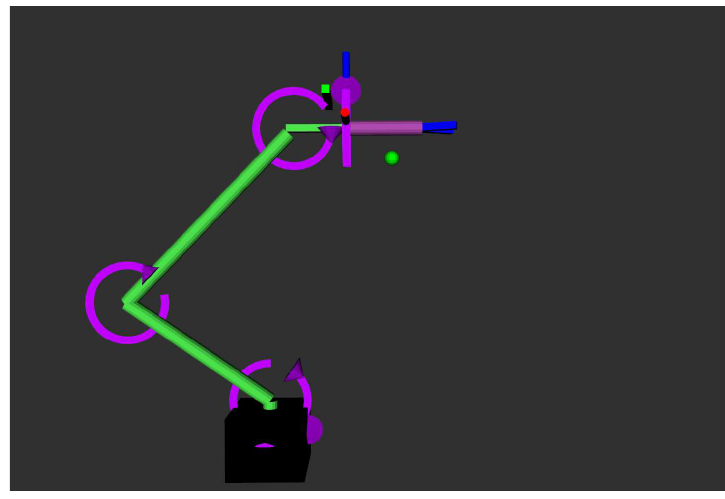
Figure 8. The manipulator structure shown in RViz simulation